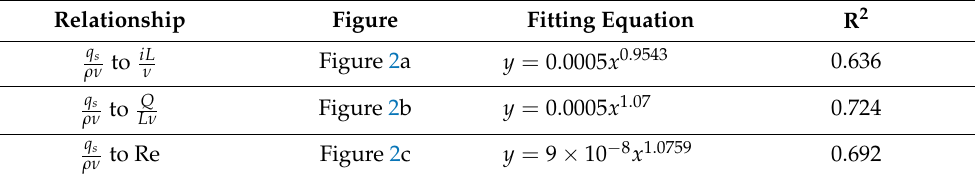
Correlation coefficients relationship of dependent to each independent